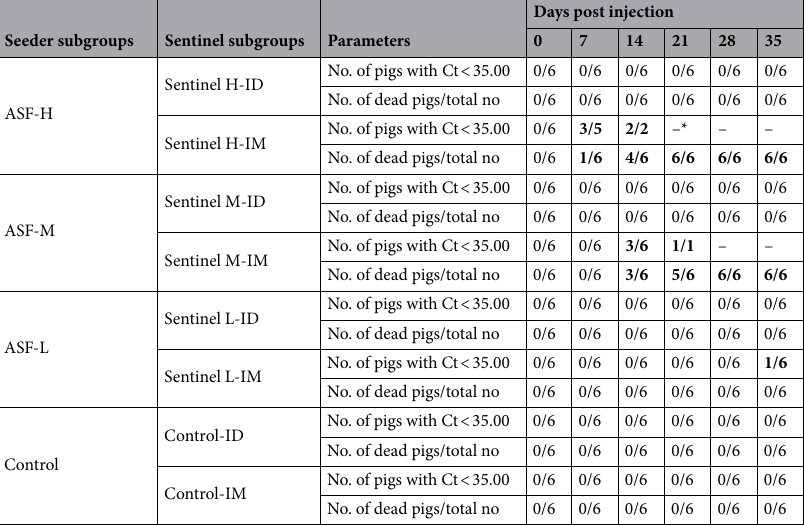
Seeder subgroups Sentinel subgroups